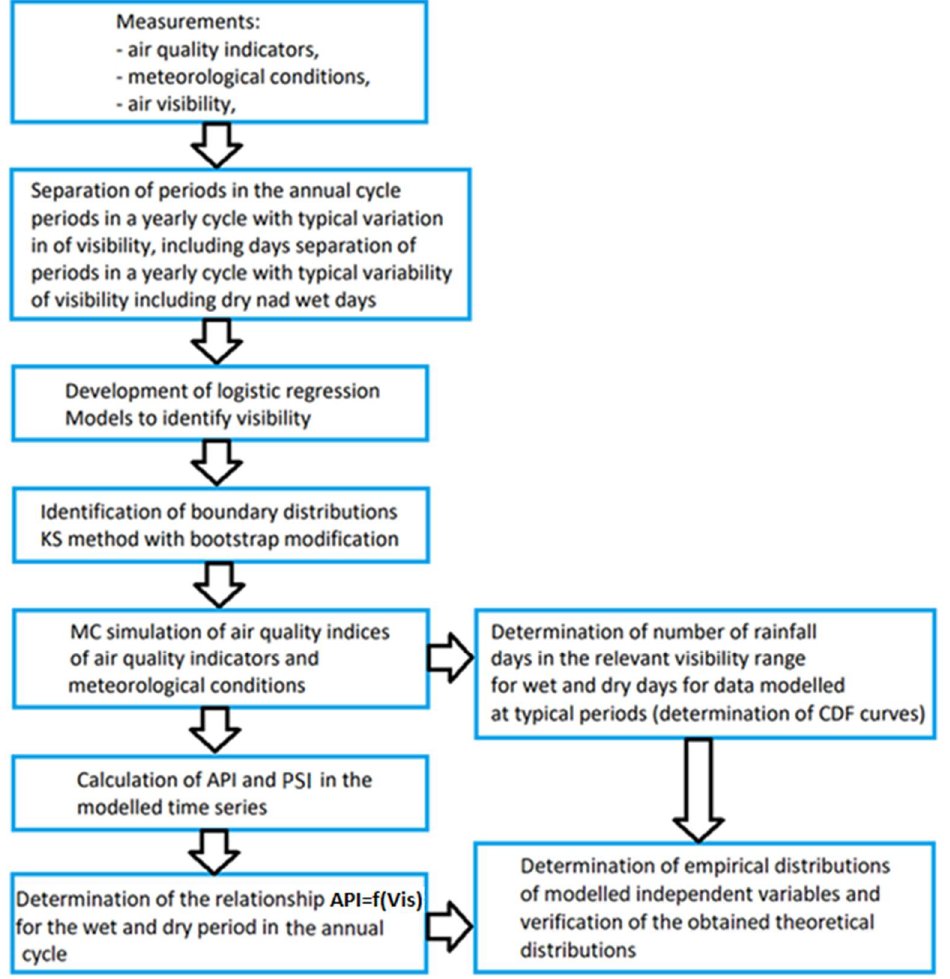
Figure 2. Model algorithm for analyzing the effect of visibility on the API for precipitation and dry days on an annual basis.